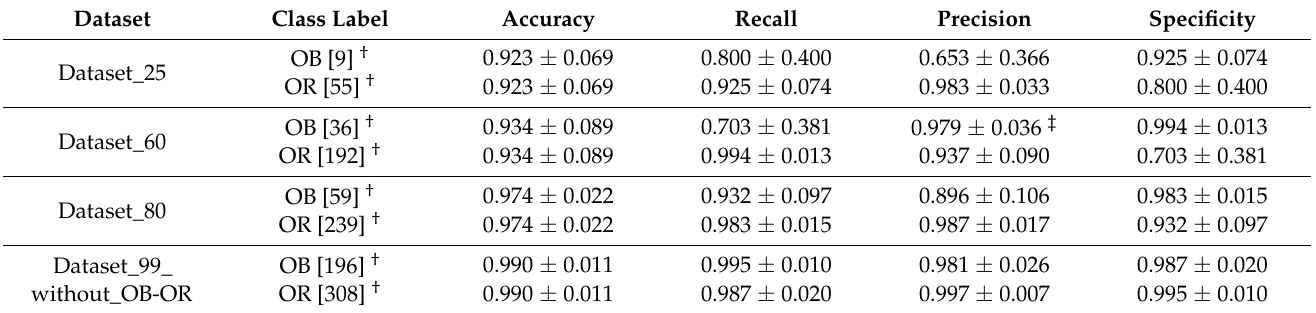
Table 5. Mean values and standard deviations of accuracy, precision, recall, and specificity obtained from two-label classification over the five-fold cross-validation runs for each